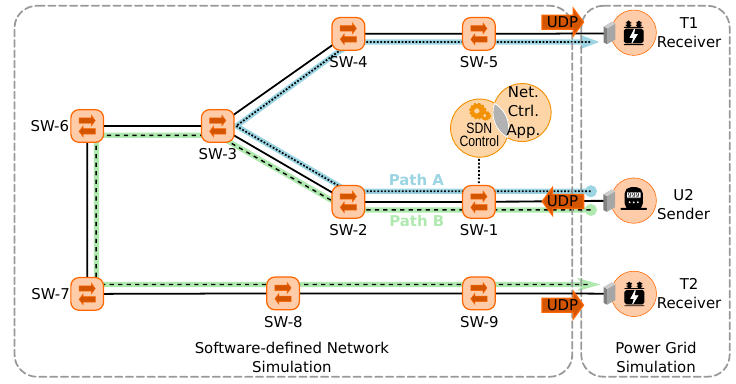
Figure 9. The SDN prototype as used within the